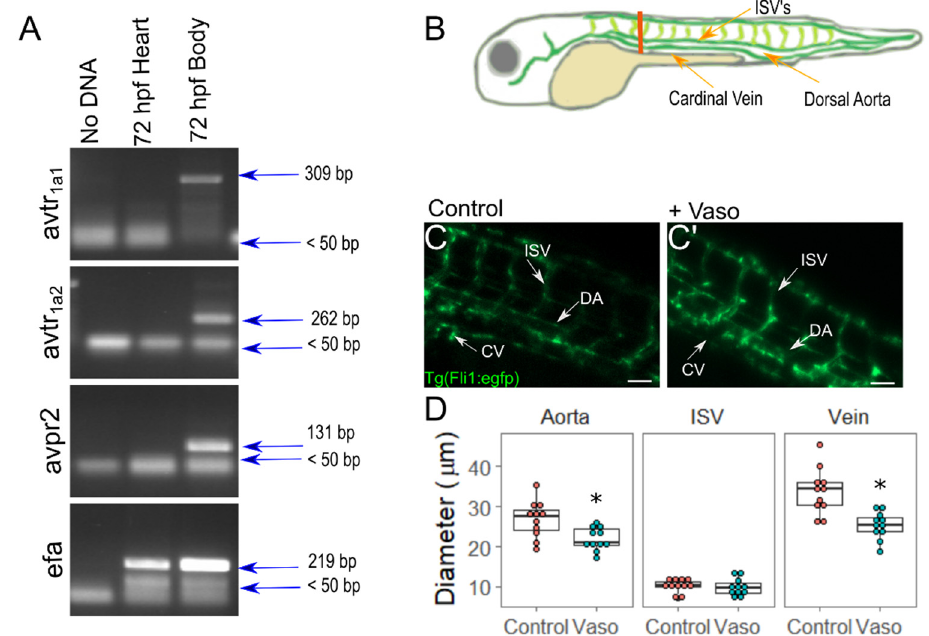
Figure 1. Application of vasopressin causes vasoconstriction of major blood vessels in zebrafish by 48 hpf. ( A ) RT-PCR of vasopressin receptors in whole body vs. cardiac tissues. ( B ) Diagram of zebrafish vasculature. The orange line indicates site of measurement. ( C ) Vasculature of control and ( C ’) vasopressin-treated embryos at 48 hpf. ( D ) Diameter of cardinal vein (CV), dorsal aorta (DA), and intersegmental vessels (ISV). For D: n = 11 for wildtype, n = 11 for vasopressin-treated embryos. Two-sided t -test was performed to validate statistical significance; * indicates p < 0.05. Scale bar represents 50 µ